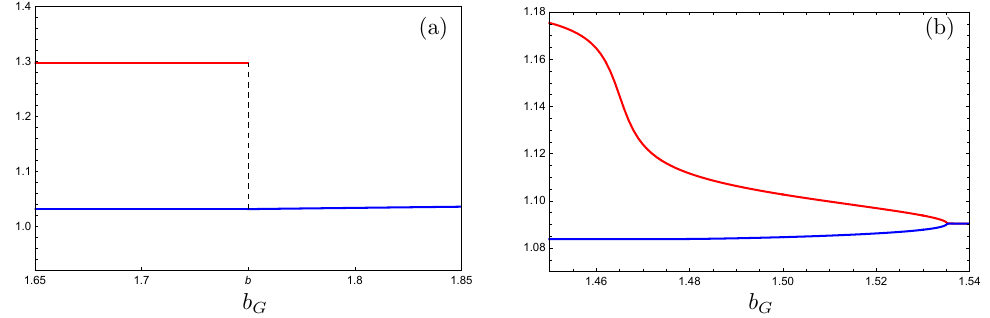
Figure 9. ( a ) the limiting maximum and minimum values of the norm of trajectories as a function of b G for the discontinuous model; ( b ) as in ( a ), but for the smooth approximation of the model with M = 10 in